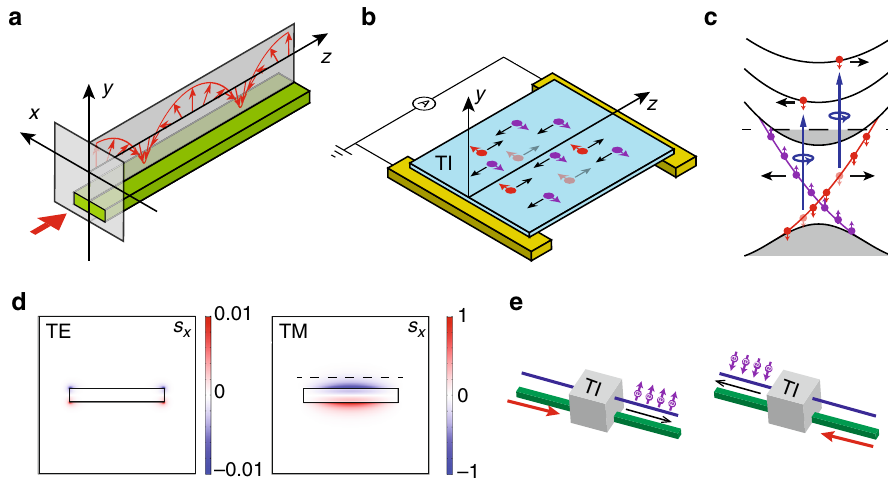
Fig. 1 Spin-momentum locking for photons and electrons. a In a waveguide mode, the evanescent electric fi eld is spinning in the propagation plane (the y – z plane) and therefore the guided photons have a SAM polarized along the transverse direction (along the x -axis). The direction of the SAM is locked to the propagation direction: along + x for propagation long + z and reverse to − x for propagation long − z . b The spin of the surface electrons in a topological insulator is locked to the transport direction. c The selection rules of optical transitions in TI with lifted spin degeneracy lead to spin-dependent photoexcitation. Circularly polarized light will selectively excite electrons with one type of spin from the surface states to the bulk bands, generating a spin- polarized photocurrent fl owing in a direction determined by the spin polarization. This is the CPGE effect. d The x -component of SAM density ( S x ) for the TE and TM mode of a silicon waveguide (1500 nm wide and 220nm high). On the top of the waveguide, S x of the TM mode is more than 100 times higher than that of the TE mode. Therefore, the TM mode has a more signi fi cant helicity-dependent effect in its evanescent fi eld. e The proposed device integrates the TI on a waveguide to explore the spin-momentum locking of electrons and photons. It outputs a spin-polarized current with its spin polarization